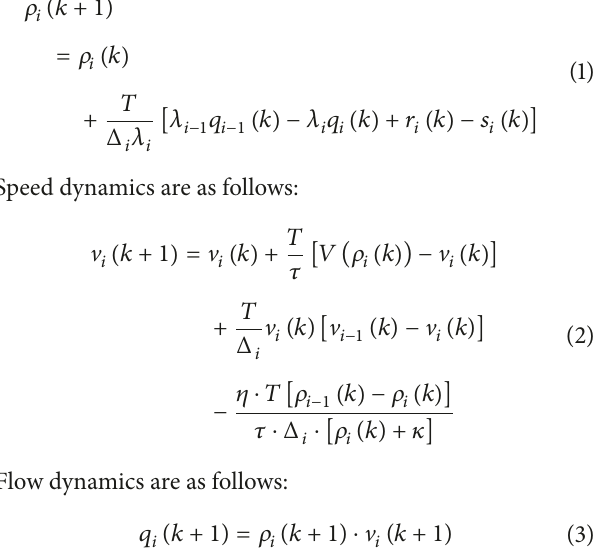
segments, the system uses a modified METANET model for traffic state prediction, and the discrete choice optimizer objective function and constraints. After optimization,